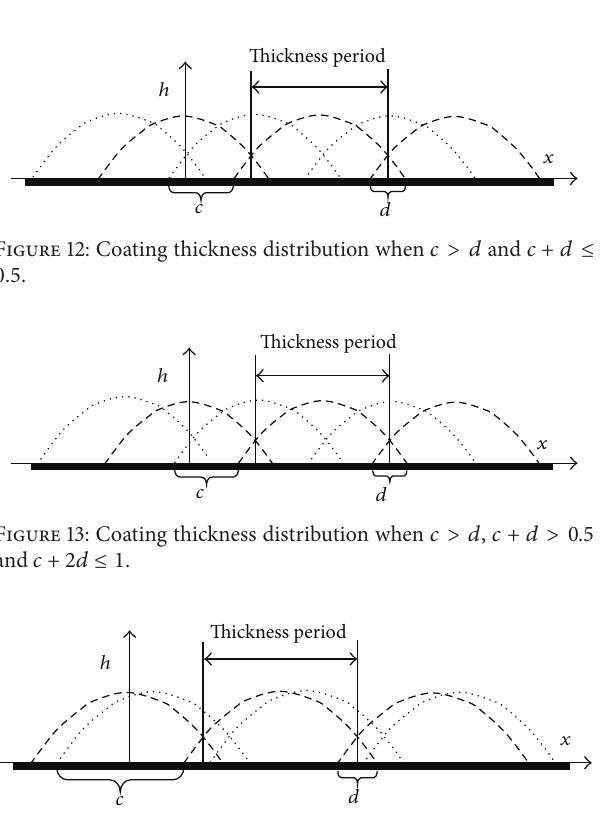
Figure 14: Coating thickness distribution when 𝑐 > 𝑑 , 𝑐 + 𝑑 > 0.5 and 𝑐 + 1.5𝑑 ≤ 1 .